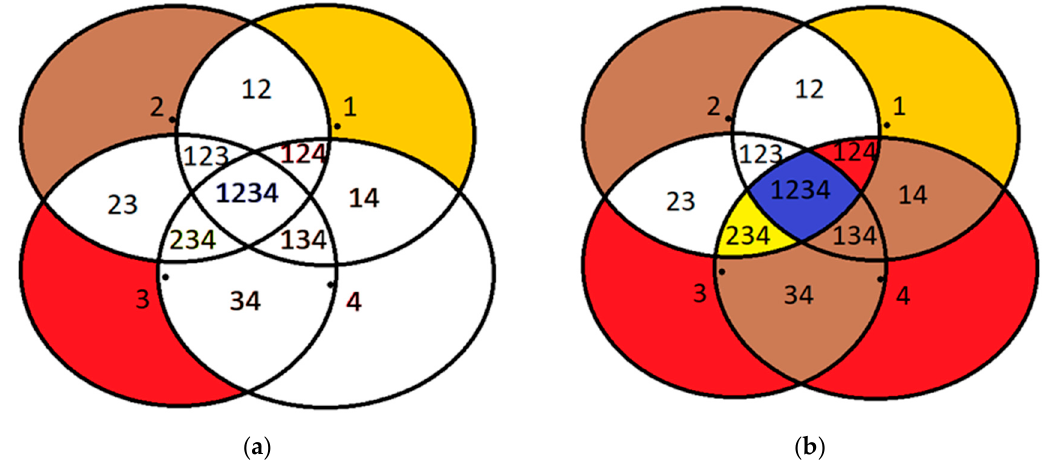
Figure 3. ( a ) Conventional Graph coloring, ( b ) implementation of DCA.